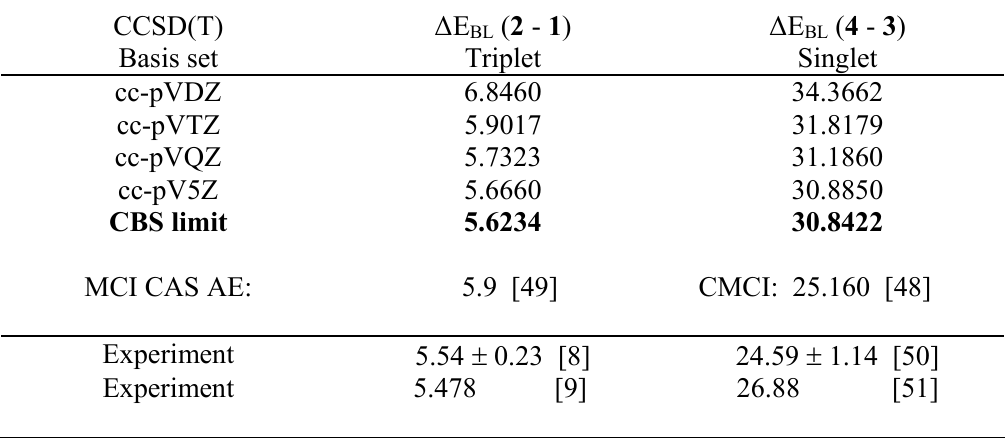
Table 7. Barriers to linearity ∆ E between bent 2 and linear 1 from Table 1) and singlet CH from Table 2).